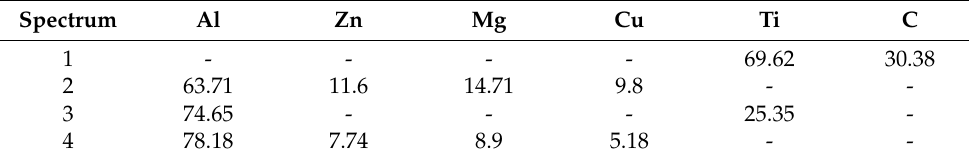
Figure 4. Particle distribution of alloys with different Ti content: ( a – c ) 0.20 wt.%; ( d ) 0.30 wt.%. Table 2. EDS results of phases in Figure 5 (at. %).